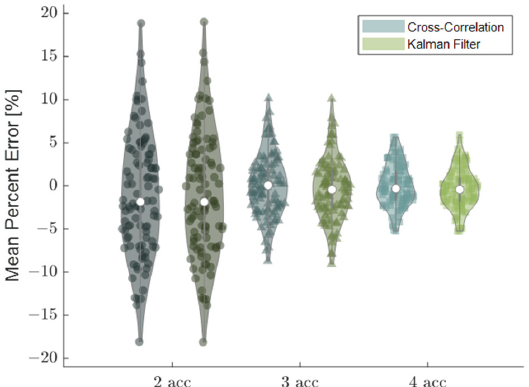
Figure 9. The Kalman filter had no effect on the mean percent error when accelerometer position was randomly varied. However, increasing the number of accelerometers in the array did substantially reduce the wave speed estimate errors.